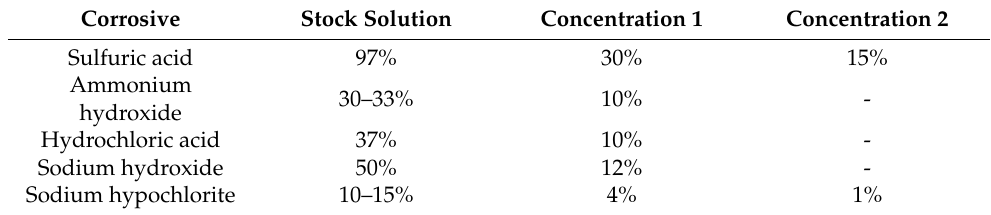
Table 1. Working concentrations of the corrosive aqueous solutions explored as analytical targets. Corrosive Stock Solution Concentration 1 Concentration 2 Sulfuric acid 97% 30% 15% Ammonium 30–33% hydroxide Hydrochloric acid 37%